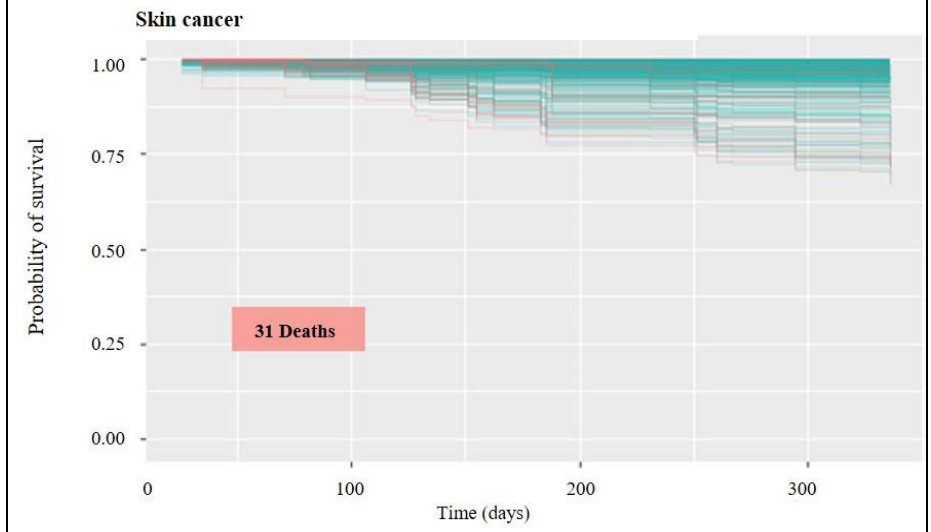
Figure 3. Skin cancer survival graph: probability of survival over time for the untrained group of patients (out-of-bag group). In the red is prediction of death occurrences and in blue is survival.